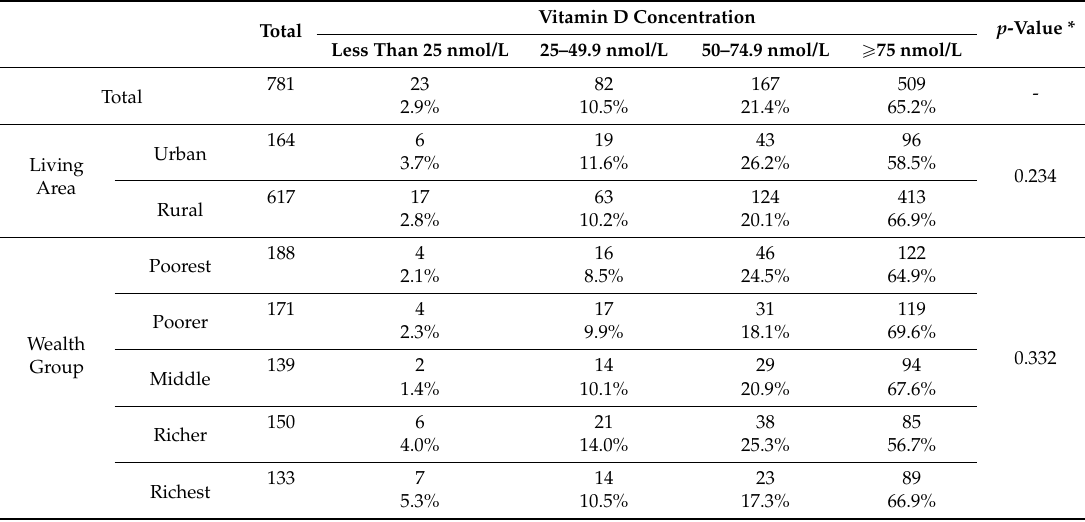
Table 4. Comparative relationships between vitamin D status, living area, and wealth grouping among